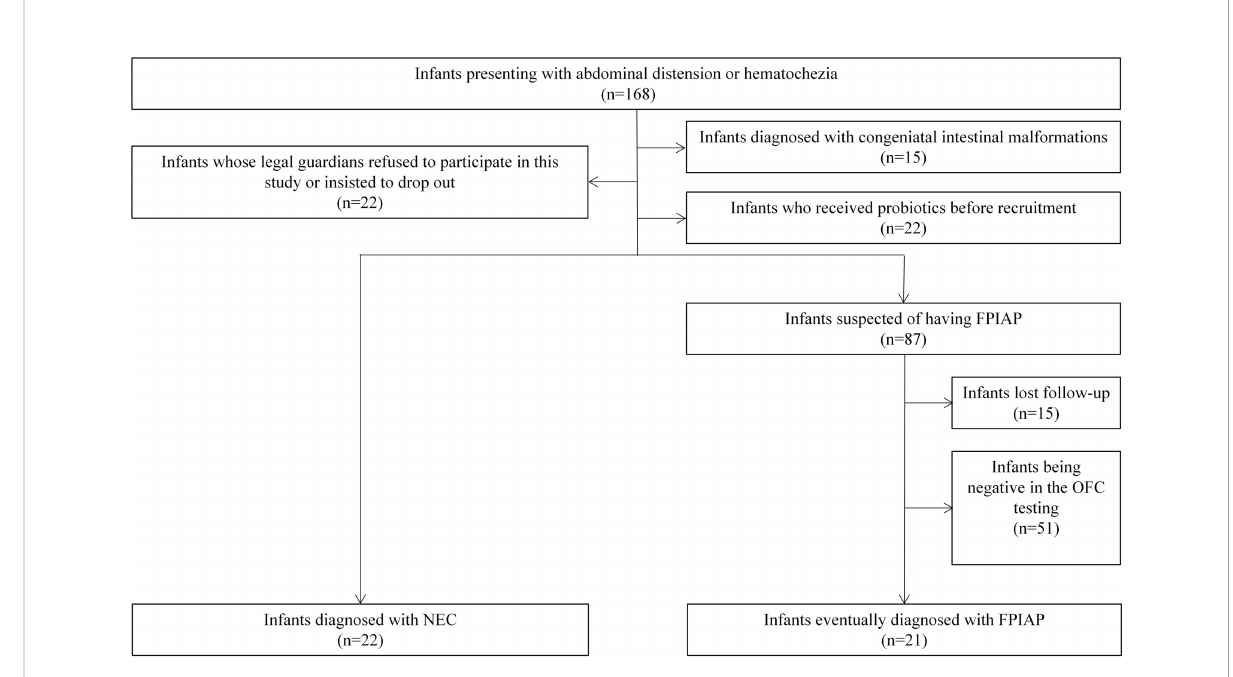
FIGURE 1 Flow diagram of the inclusion and exclusion processes of the